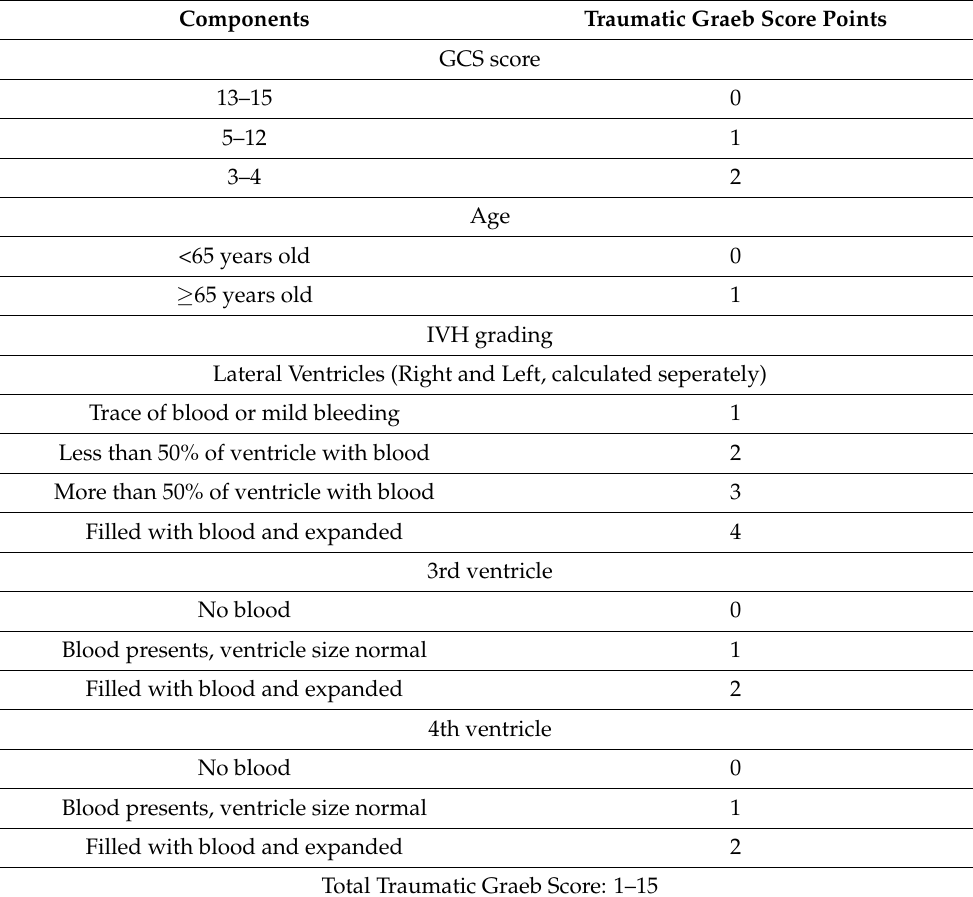
Table 5. Components of the novel Traumatic Graeb